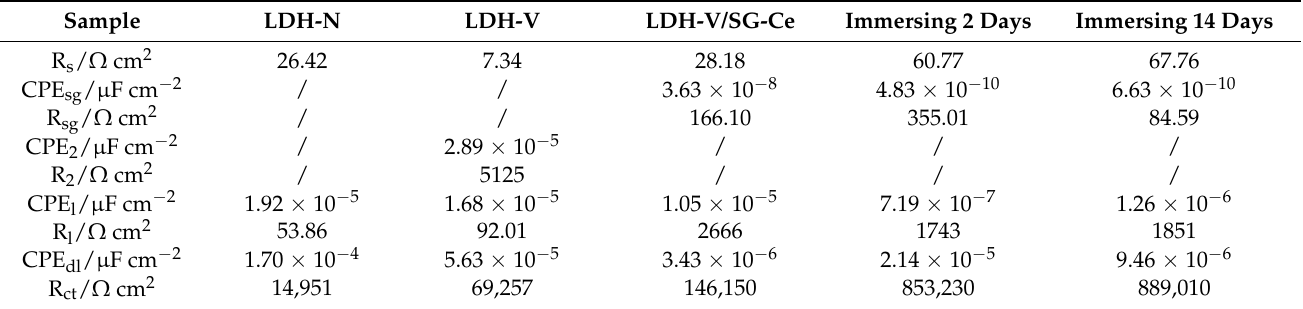
Table 2. EIS fitting parameters of the coating systems.